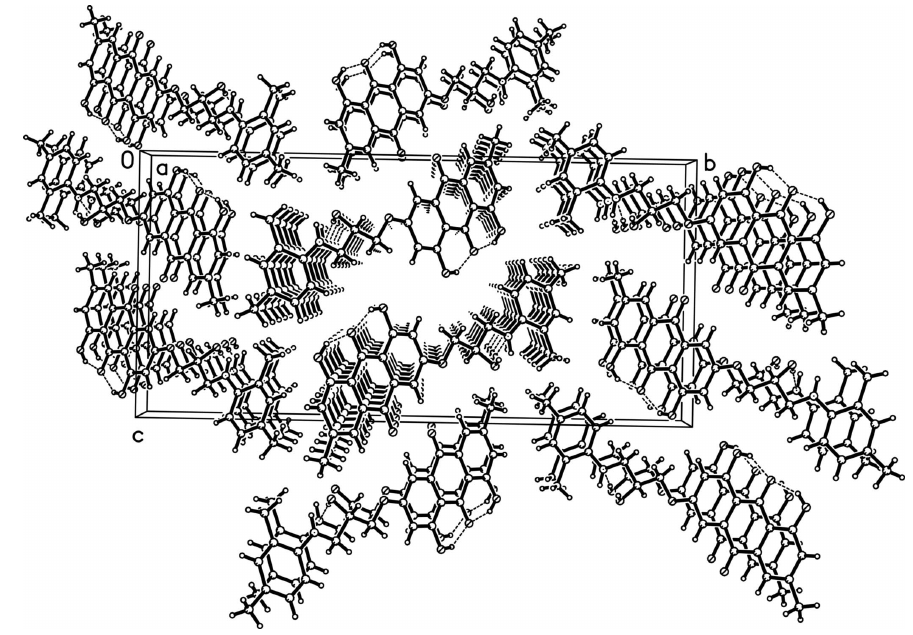
The molecular packing of the title compound, viewed along the a axis. Dashed lines indicate hydrogen-bonding